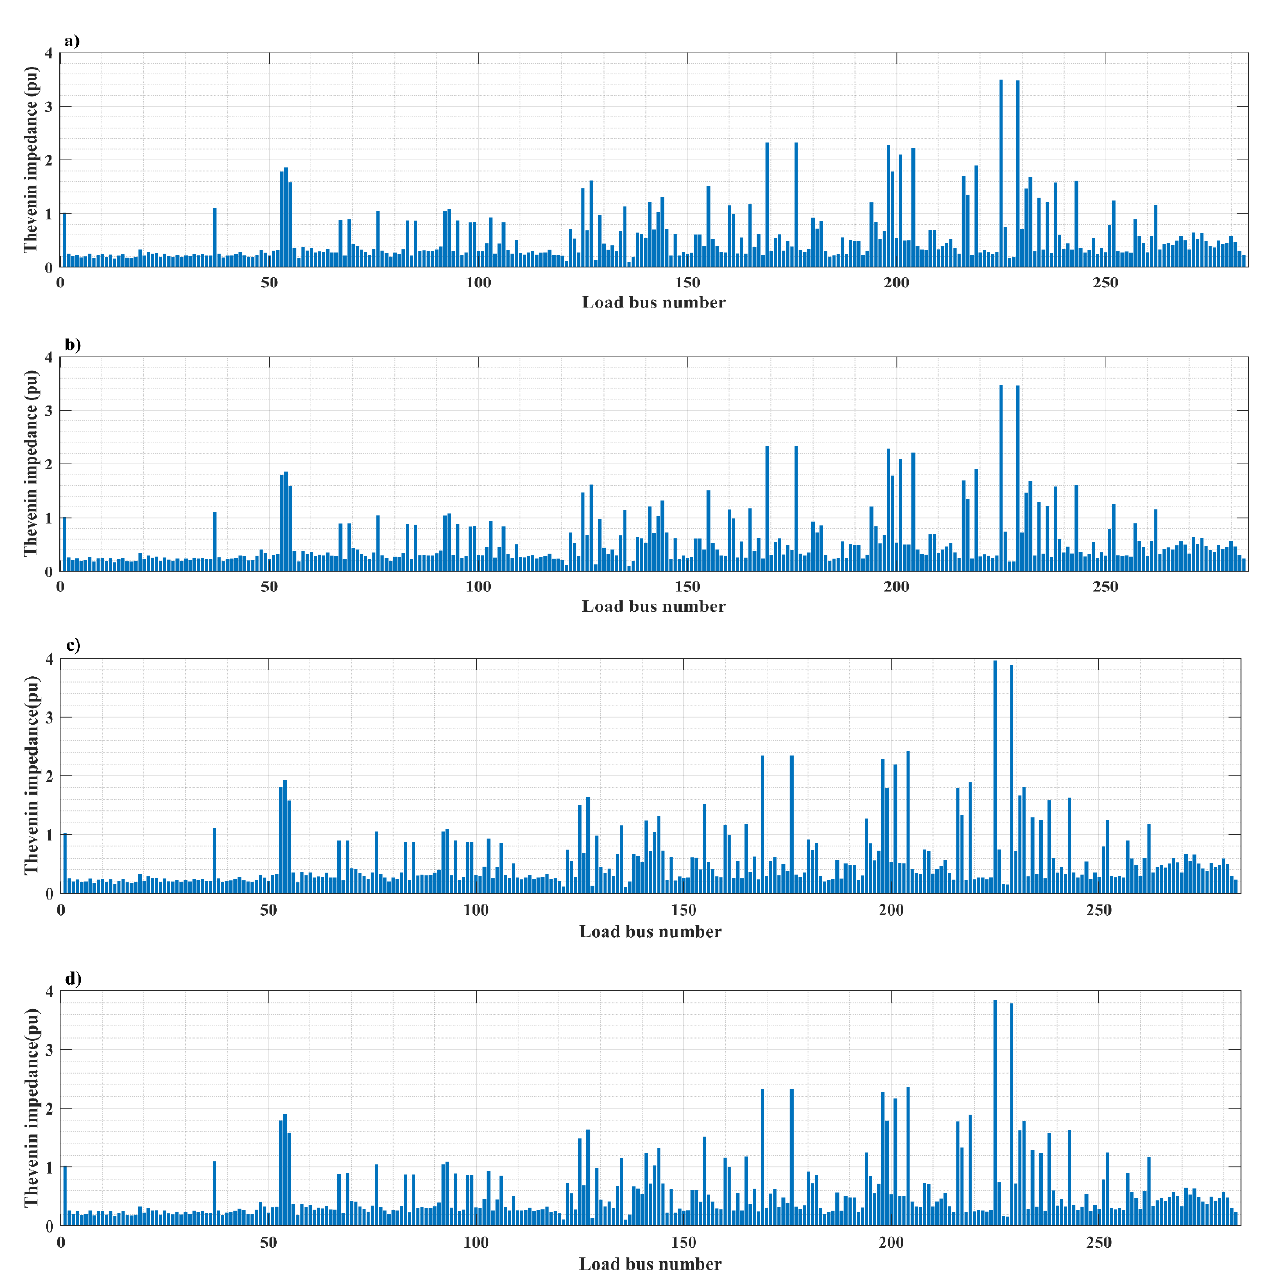
Figure 6. Thevenin impedance seen by the load buses a) Light load uncompensated system b) Light load compensated system c) Heavy load uncompensated system d) Heavy load compensated